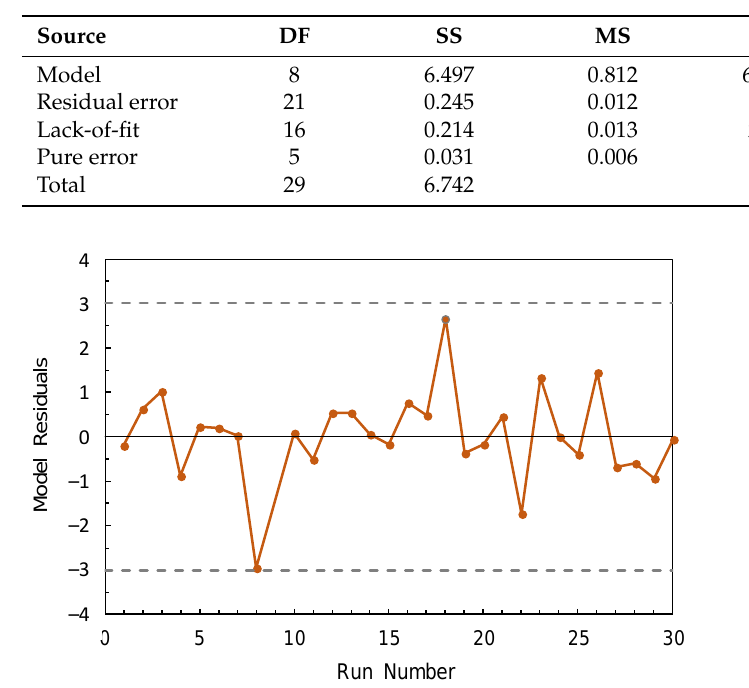
Table 4. ANOVA results for the reduced model described by Equation (2). DF denotes the degrees of